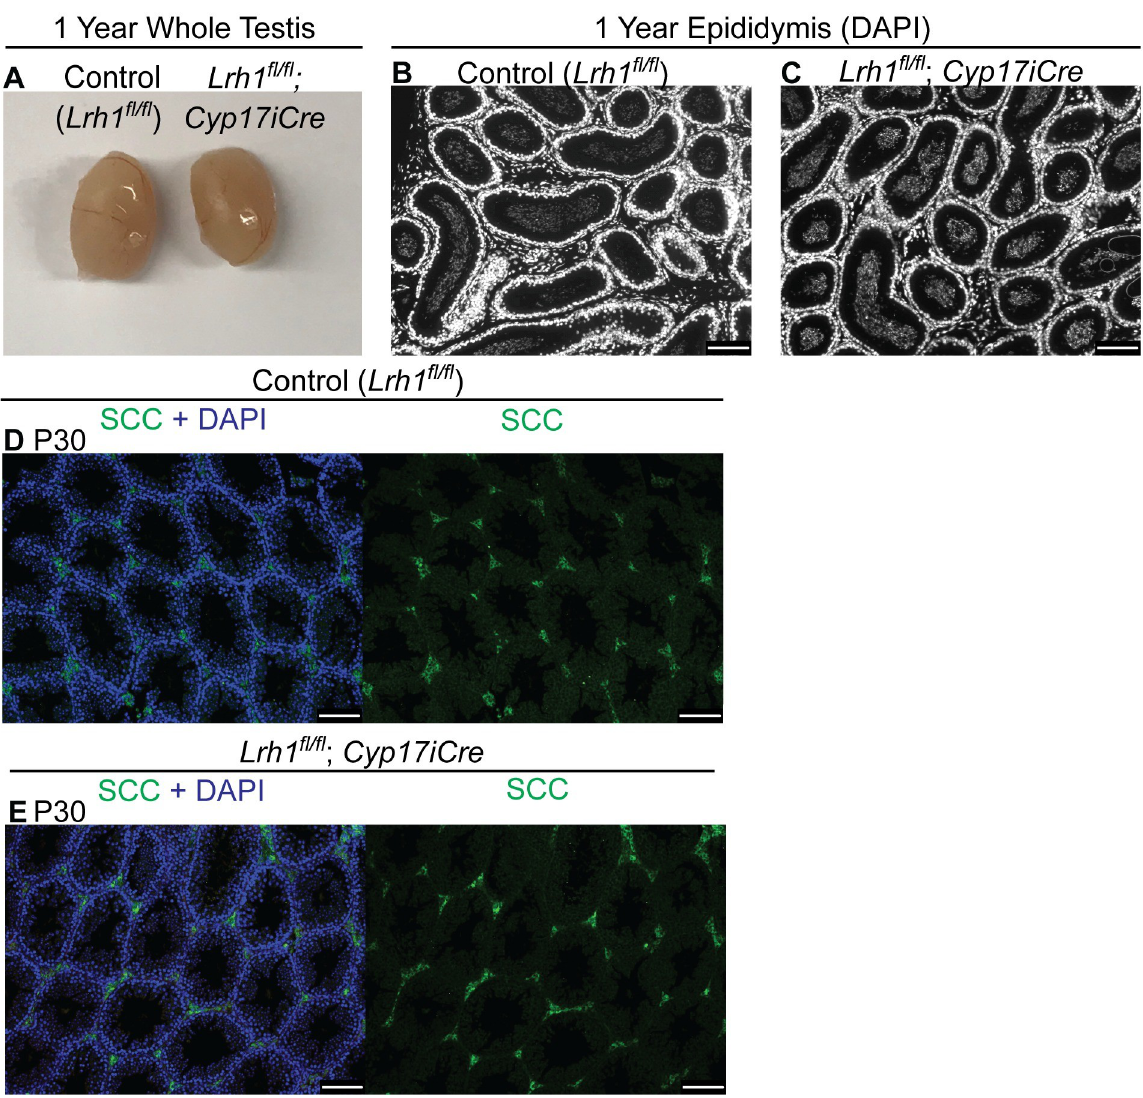
Fig 5. Normal testis size, spermatogenesis and Leydig cell development in Leydig cell conditional mutants. (A) Intact testes from one year control and Leydig cell conditional homozygous mutant. (B,C) DAPI fluorescence of epididymis from one year control and Leydig cell conditional mutant. (D,E) IF of control and Leydig cell conditional Lrh1 mutant testes at P30 stained for Leydig cell marker SCC (green) and DAPI (blue). Scale bars: 100 um.